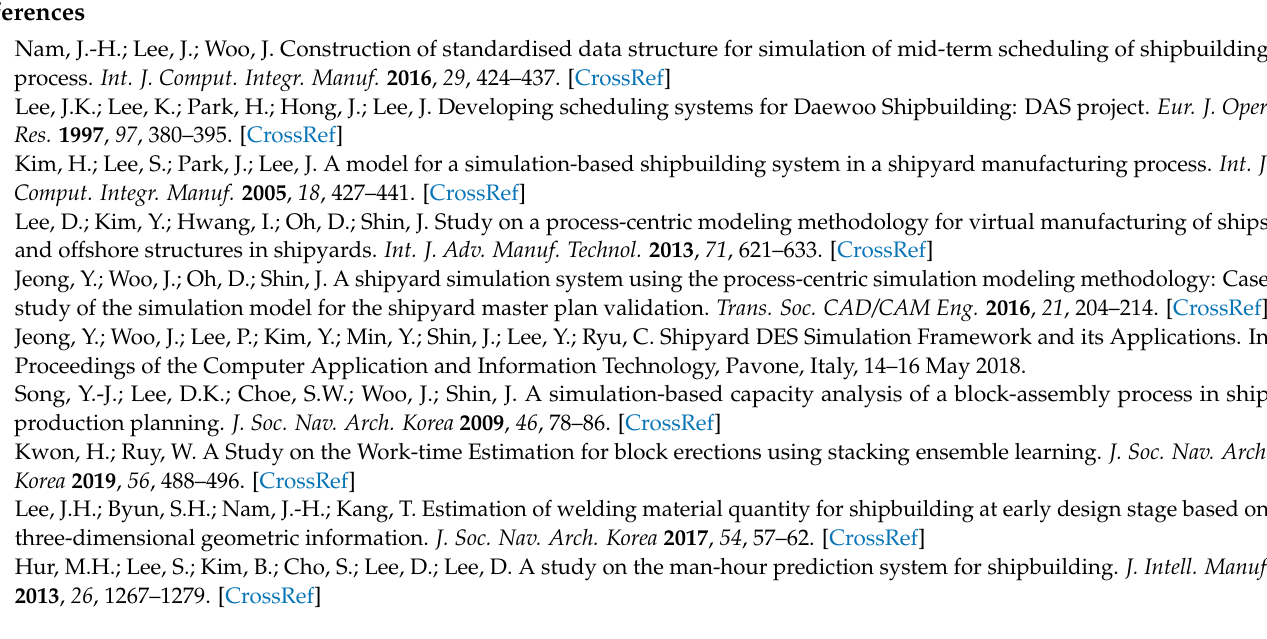
Table A1. Minimum leg length for plate thickness.